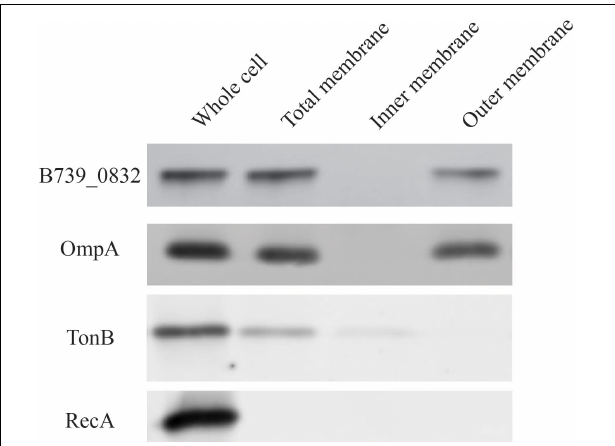
FIGURE 3 | Survival rate in ducklings infected by R. anatipestifer CH-1, (cid:49) B739_0832 , or C (cid:49) B739_0832 strains. Each group has 10 3-day-old ducklings, which was injected intramuscularly at a dose of 10 10 CFU to assess the survival rate. The group shown in red was injected with wild-type R. anatipestifer CH-1. The orange group was injected with (cid:49) B739_0832 . The green was injected with C (cid:49) B739_0832 . Blue represents the control injected with phosphate-buffered saline (PBS). Data were analyzed using a Log-rank (Mantel–Cox) test. Three stars indicate significant difference ( p <